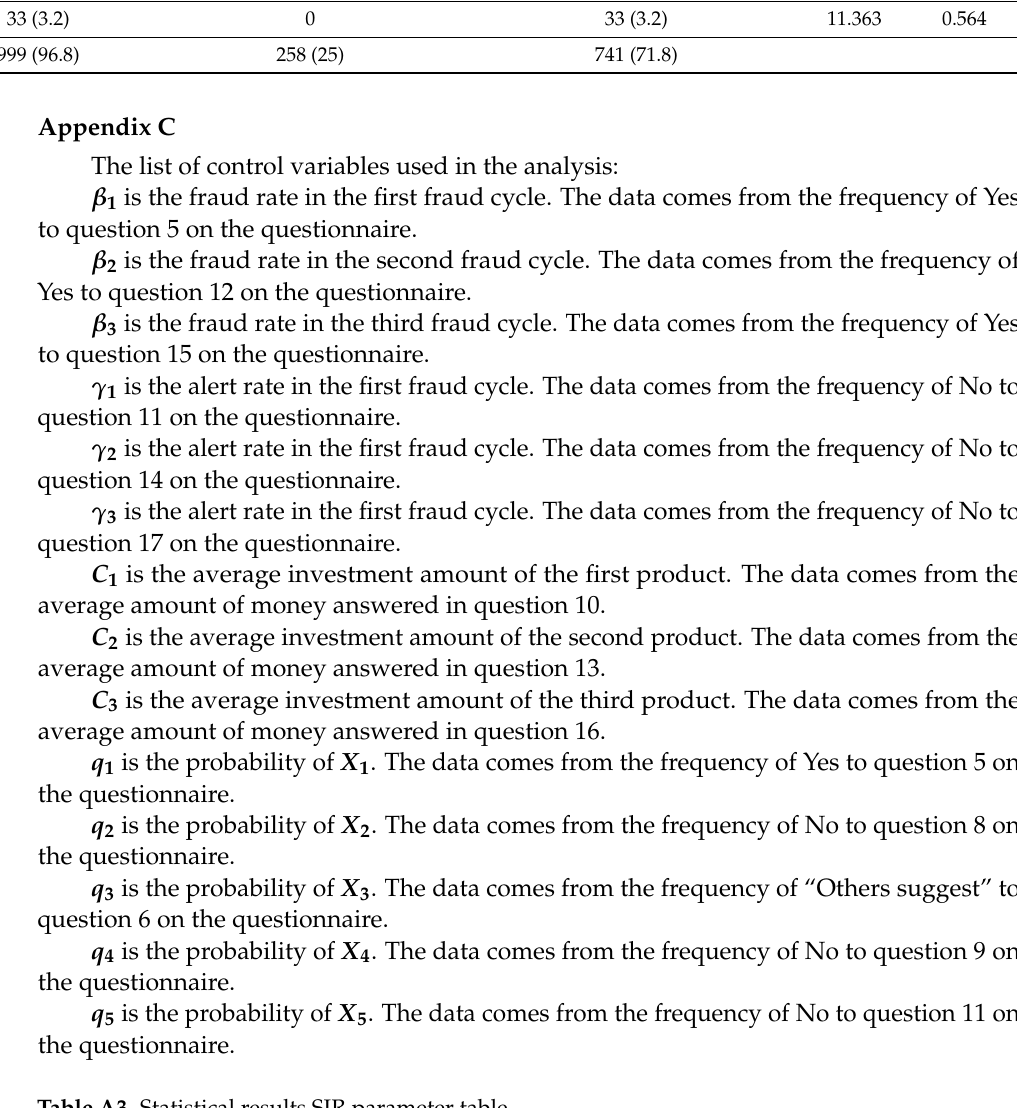
Table A3. Statistical results SIR parameter